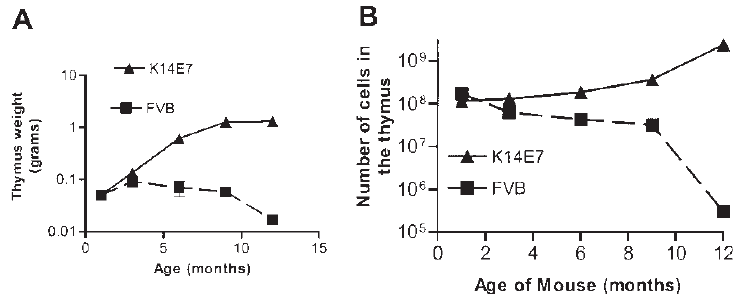
FIGURE 1 Failure of the K14E7 mouse thymus to involute with age. Thymic weight (A) and cellularity (B) are shown for K14E7 tg and non-tg FVB thymus. Weights and cell counts are the means ^ SEM for 4–5 mice at each age.